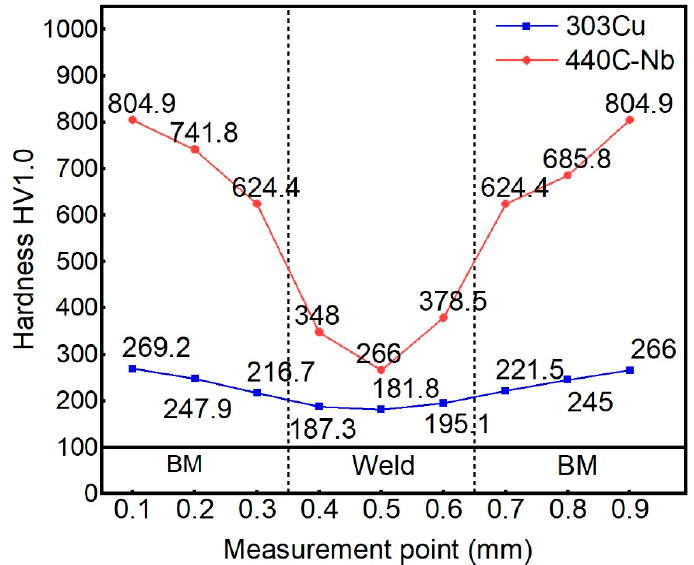
Figure 11. Vickers microhardness